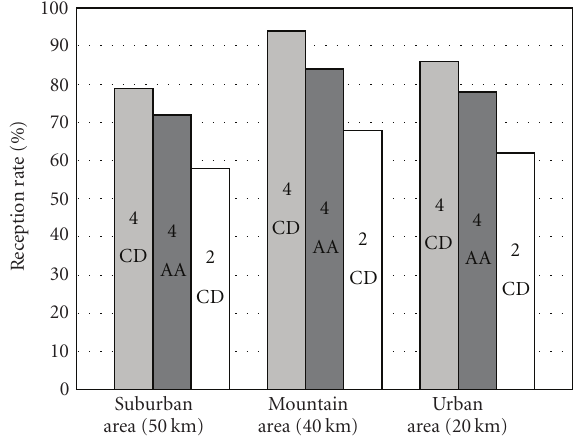
Figure 14: Field experimental